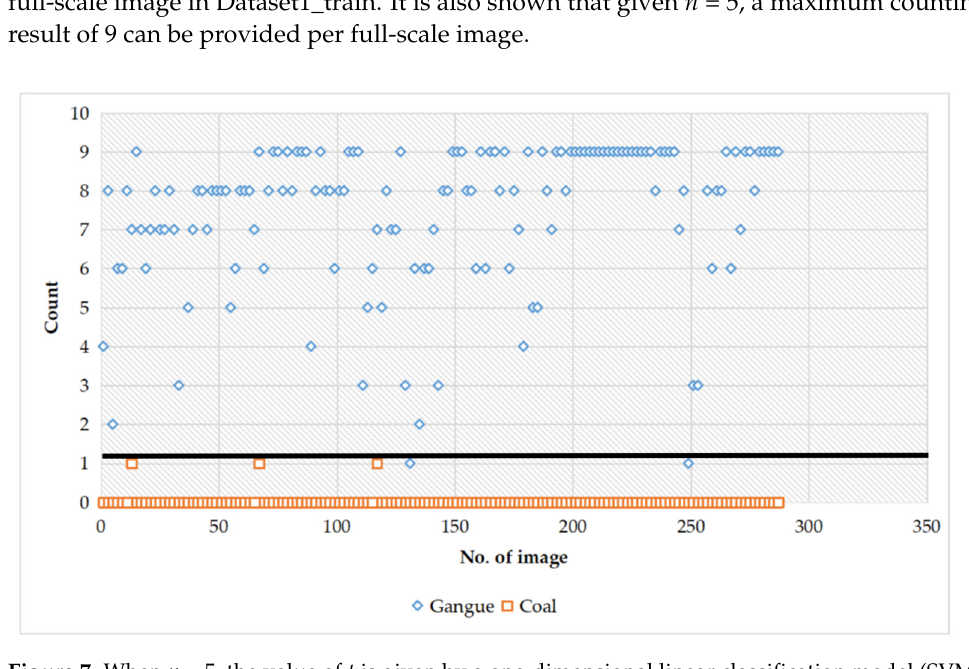
Figure 7. When n = 5, the value of t is given by a one-dimensional linear classification model